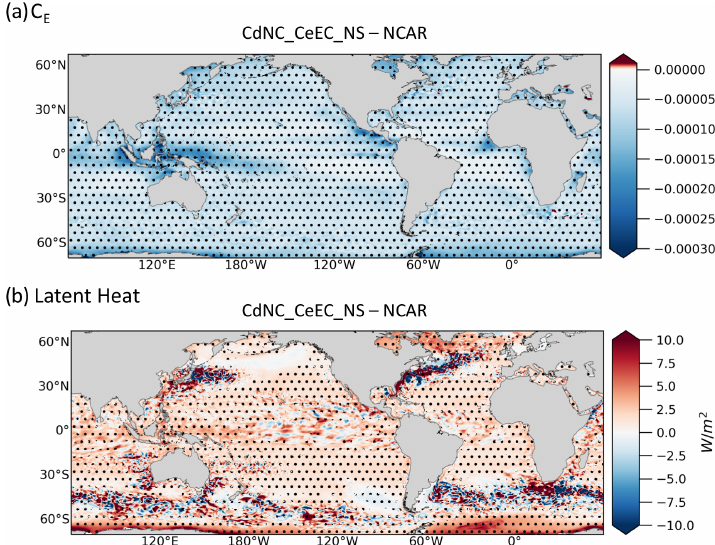
Figure 8. Annual mean differences in (a) specific humidity transfer coefficient ( C E ) and (b) latent heat between CdNC_CeEC_NS and NCAR .